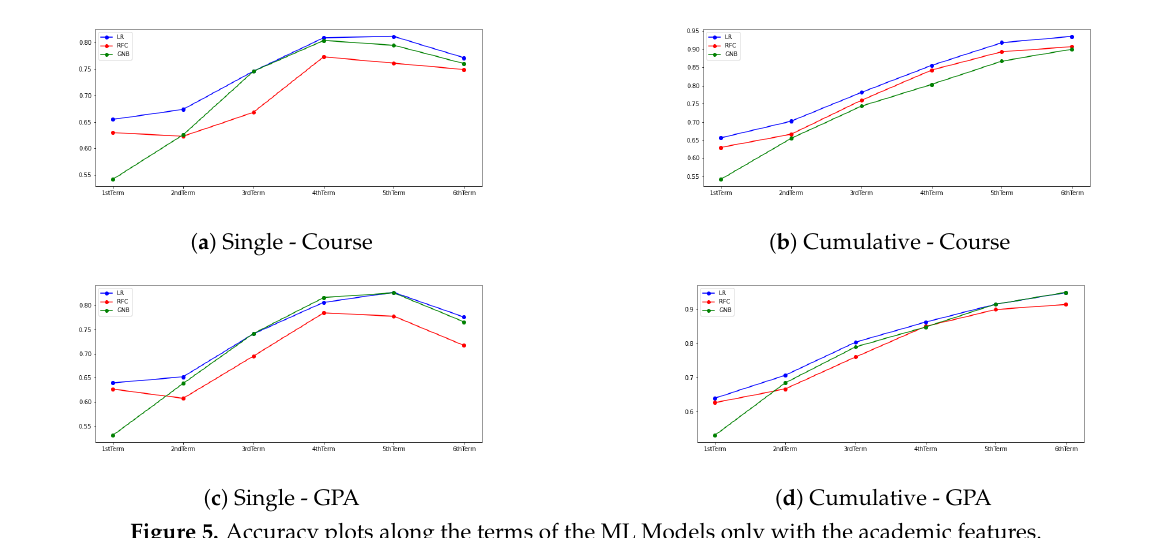
Figure 5. Accuracy plots along the terms of the ML Models only with the academic features.